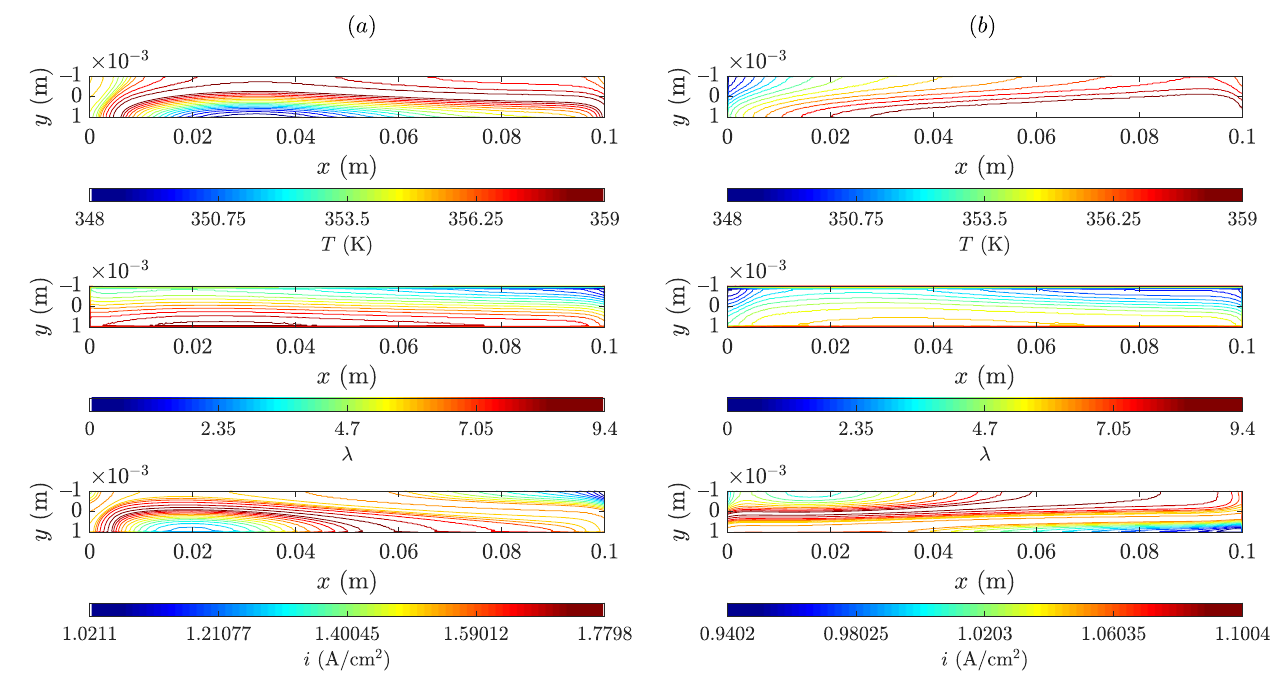
Figure 11. Membrane mid-plane temperature, water content and through-plane current density for the SIGRACET 34BC (with MPL) case: ( a ) low voltage, 0.45 V, ( b ) medium voltage, 0.65